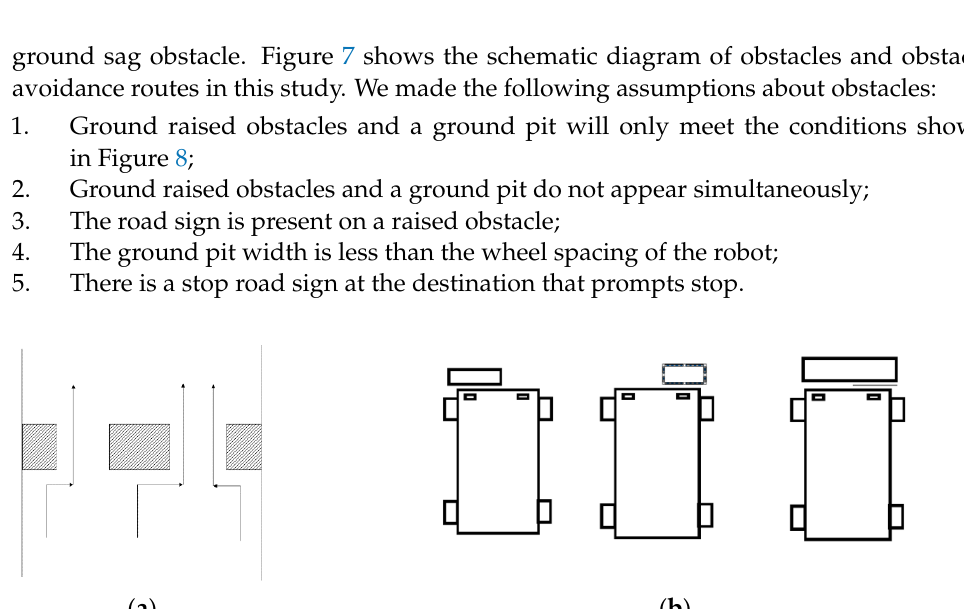
Figure 6. Identification flow chart.